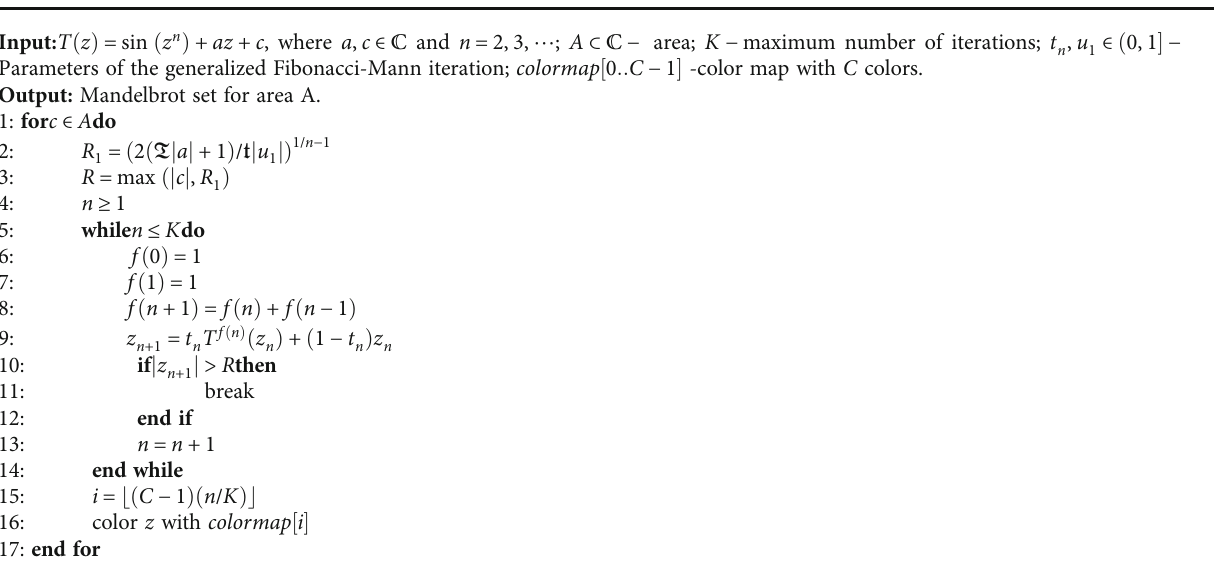
Algorithm 2: Geometry of Mandelbrot set.